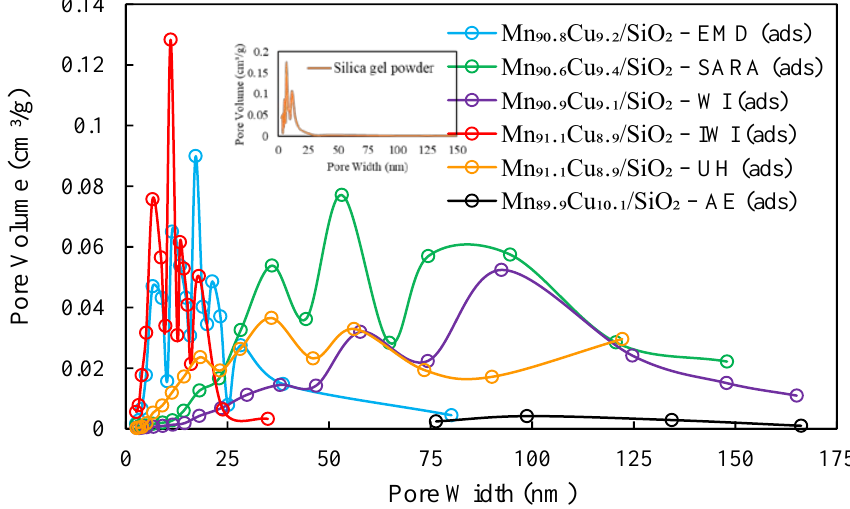
Figure 4. Pore distribution of the Mn–Cu oxide catalysts supported by the silica gel powder.